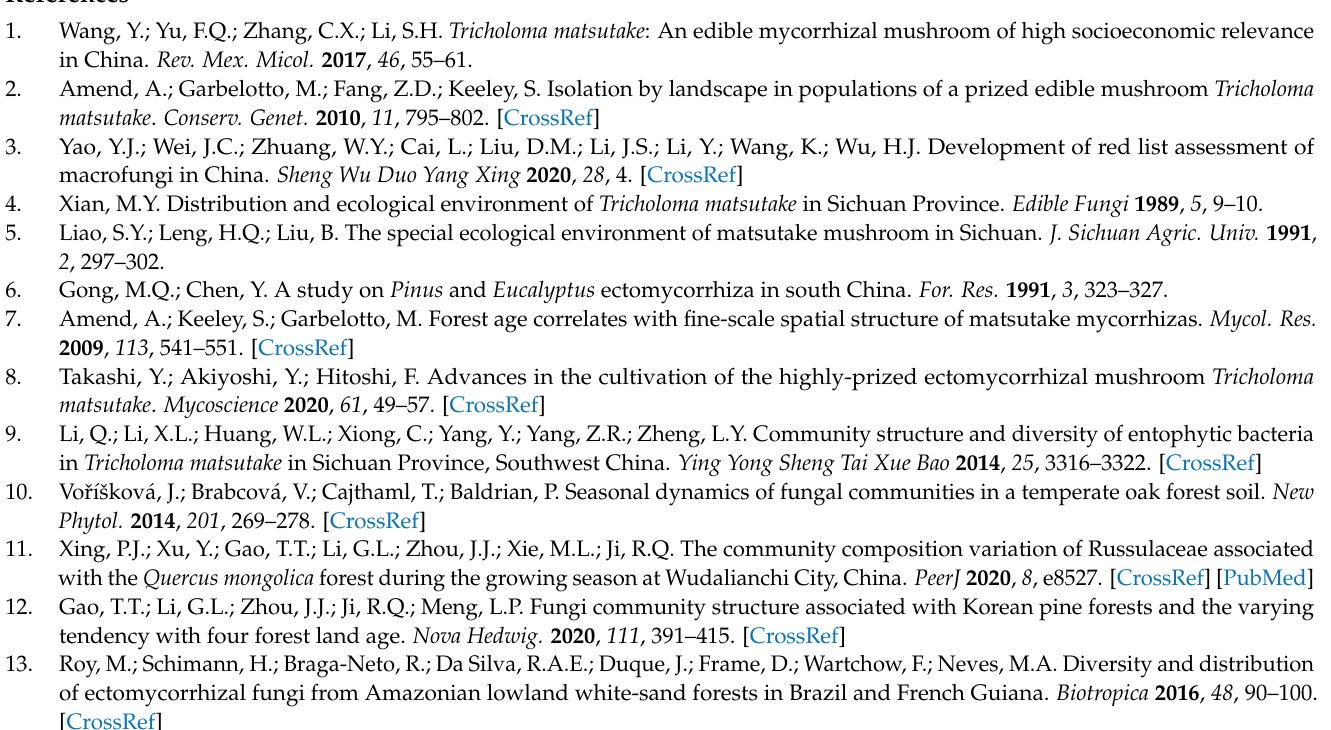
Figure S2: LefSe analysis of fungi and bacteria in the soil from three plots; Figure S3: Differential metabolic pathways. Table S1: The dominant bacterial genera and their relative abundance in the soil of three plots; Table S2: The dominant fungal genera and species compositions of Tricholoma in the soil of three plots; Table S3: Spearman correlation analysis of the relative abundance of Tricholoma with other fungi in the habitat soil; Table S4: Spearman correlation analysis of the relative abundance of Tricholoma with bacteria genera in the habitat soil. Table S5: Statistical tables of metabolic pathways based on MetaCyc